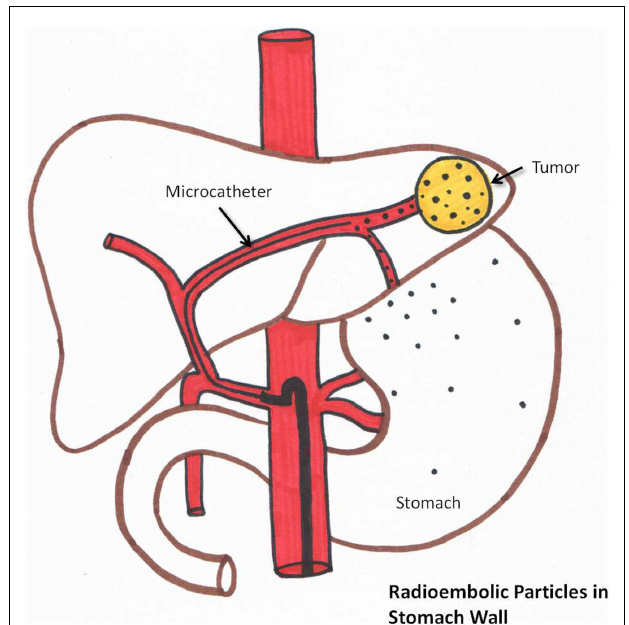
FIGURE 6 | Schematic representation of aberrant microsphere deposition in the stomach/intestine which can occur due to hepaticogastric communicating arteries